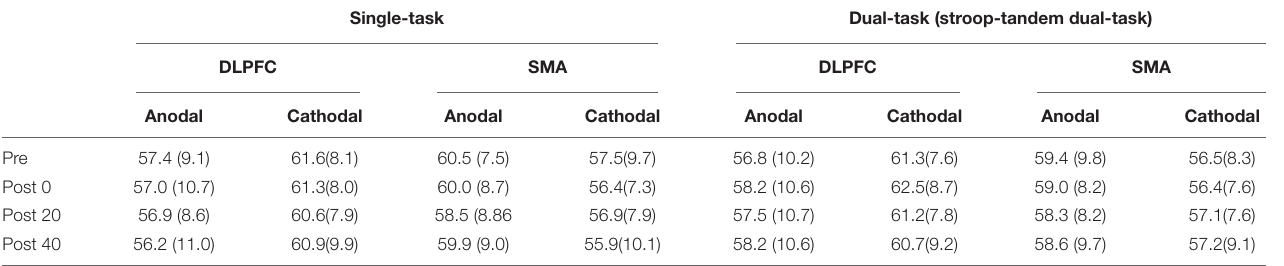
TABLE 3 | The result of the concordant word number (words) in the Stroop task under the single- and dual-task condition.